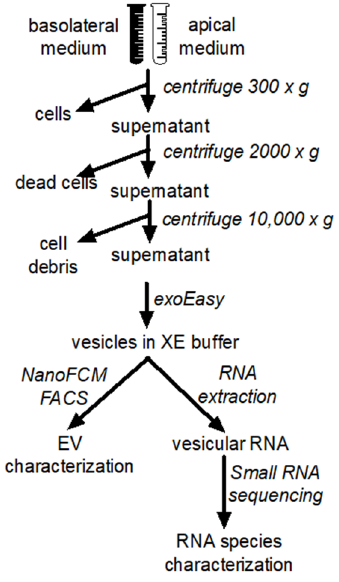
Figure 1. Schematic overview of EV preparation steps.